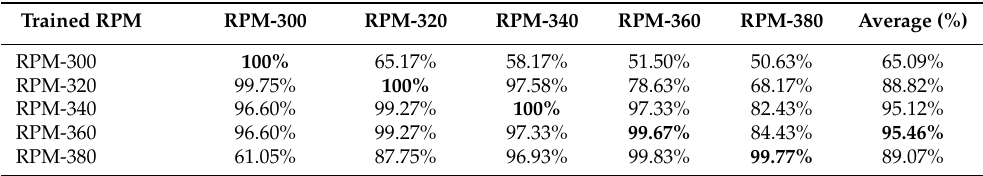
Table 7. Comparison on the performance of binary classifier detection model where the trained model is using one RPM and the tested data is from another RPM. The average accuracy is higher, compared to the three classes defect classification models.